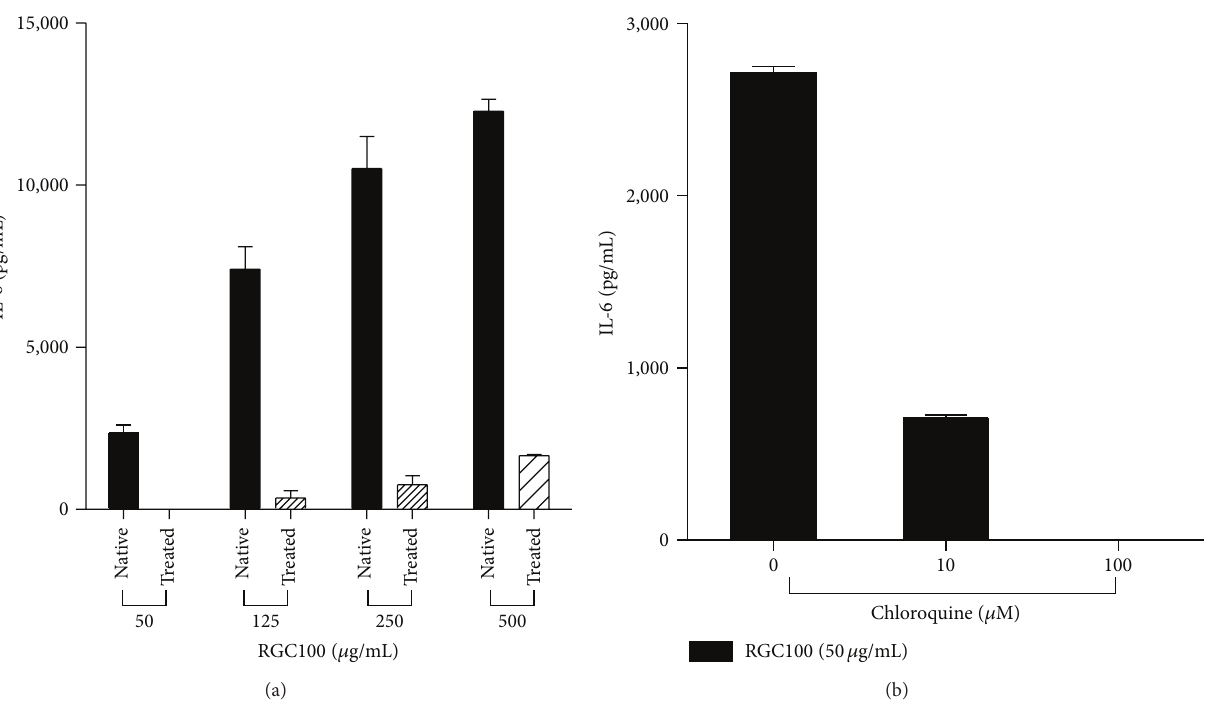
Figure 5: Inhibition of activation by RGC100 of JAWS II DCs through chloroquine. (a) Cells were first treated with chloroquine (treated, 100 𝜇 M) or not (native), then incubated with RGC100 at the indicated concentrations. (b) Cells were first treated with chloroquine at the indicated concentrations, then incubated with RGC100 (50 𝜇 g/mL). Secretion of IL-6 was measured in supernatant by ELISA. Values shown are mean ± SEM of two independent measures. Negative control consists of supernatant of cells incubated in the absence of RGC100. Values of negative control have been subtracted from the values represented on the